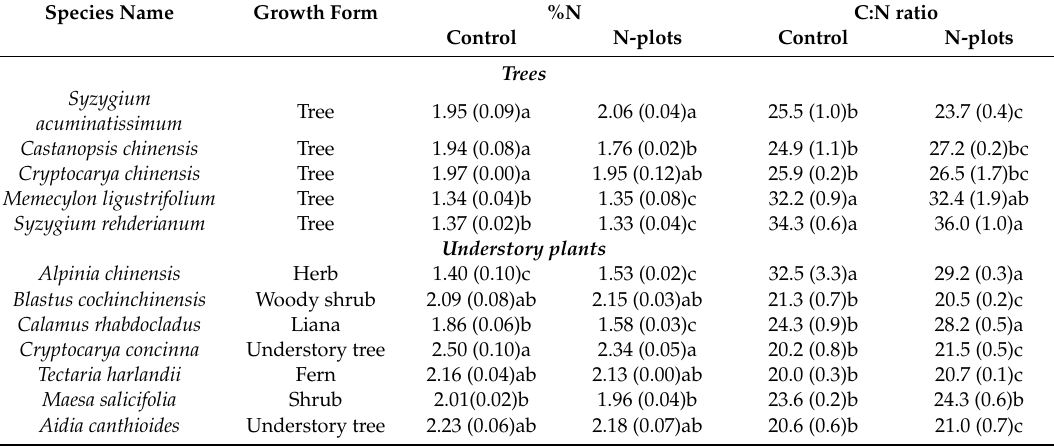
Table 1. Mean leaf %N and C:N ratio for dominant tree species and understory plant species in the control and N-plots at Dinghushan Biosphere Reserve (DHSBR) sampled in January 2013. Values in parentheses show SE among plots ( n = 3). Di ff erent lowercase letters for each variable within each treatment plots and each plant group (tree and understory) indicate significant di ff erences among plant species ( p ≤ 0.05). No significant di ff erences in leaf %N or C:N ratio were observed among control and N-plots for any